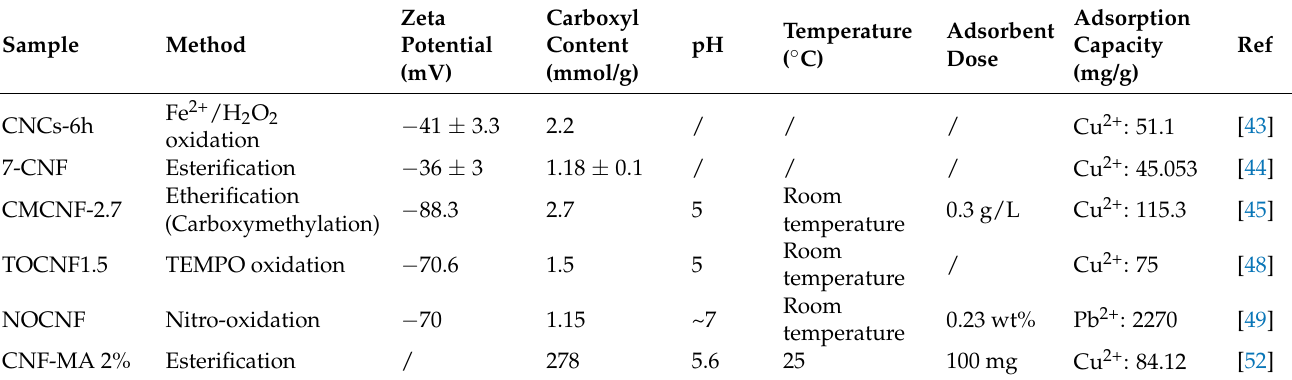
Table 2. Preparation method and properties of carboxyl-containing